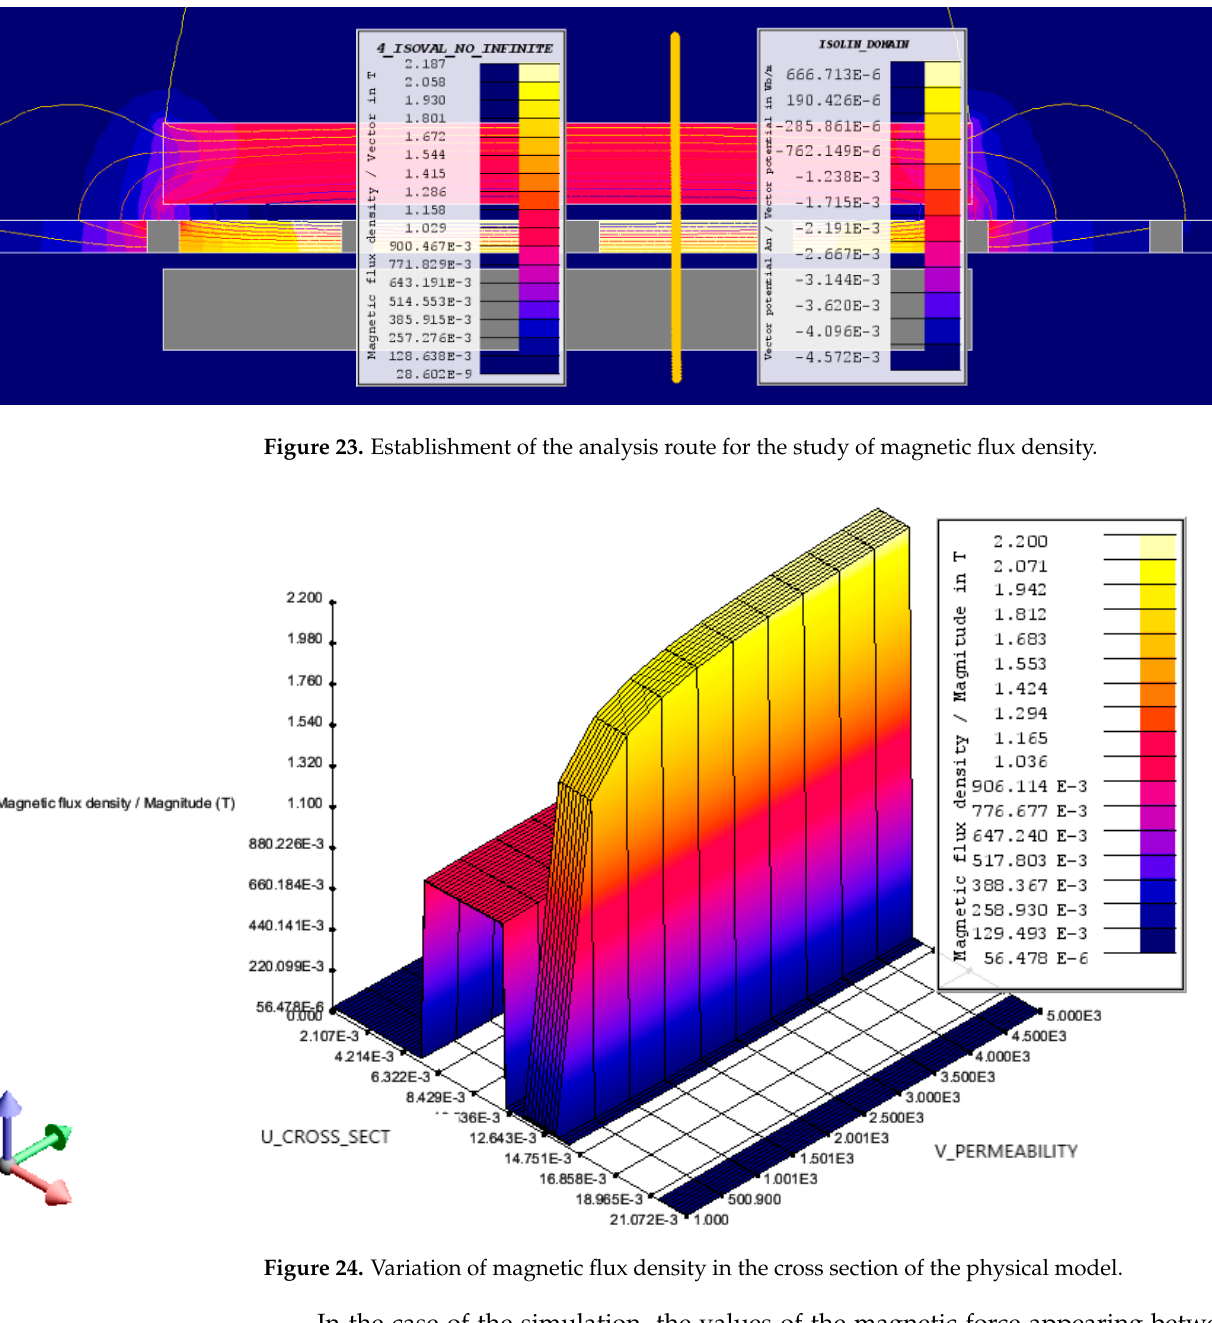
Figure 24. Variation of magnetic flux density in the cross section of the physical model.